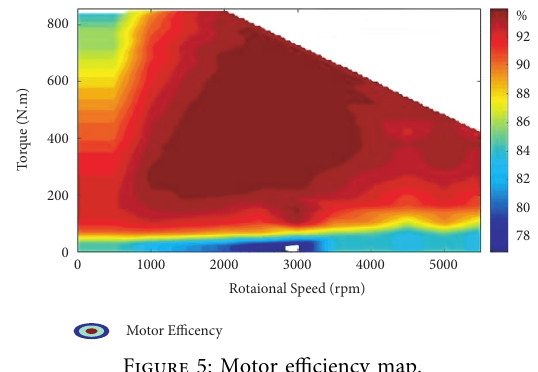
Figure 5: Motor efficiency map.